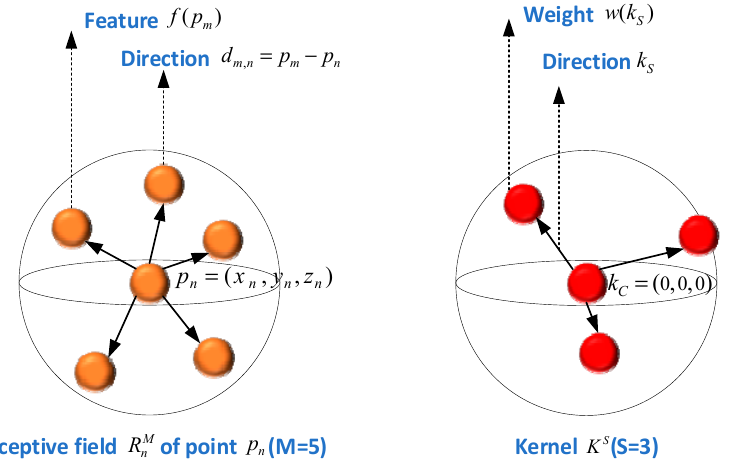
Figure 9. Receptive field R M n and kernel K S